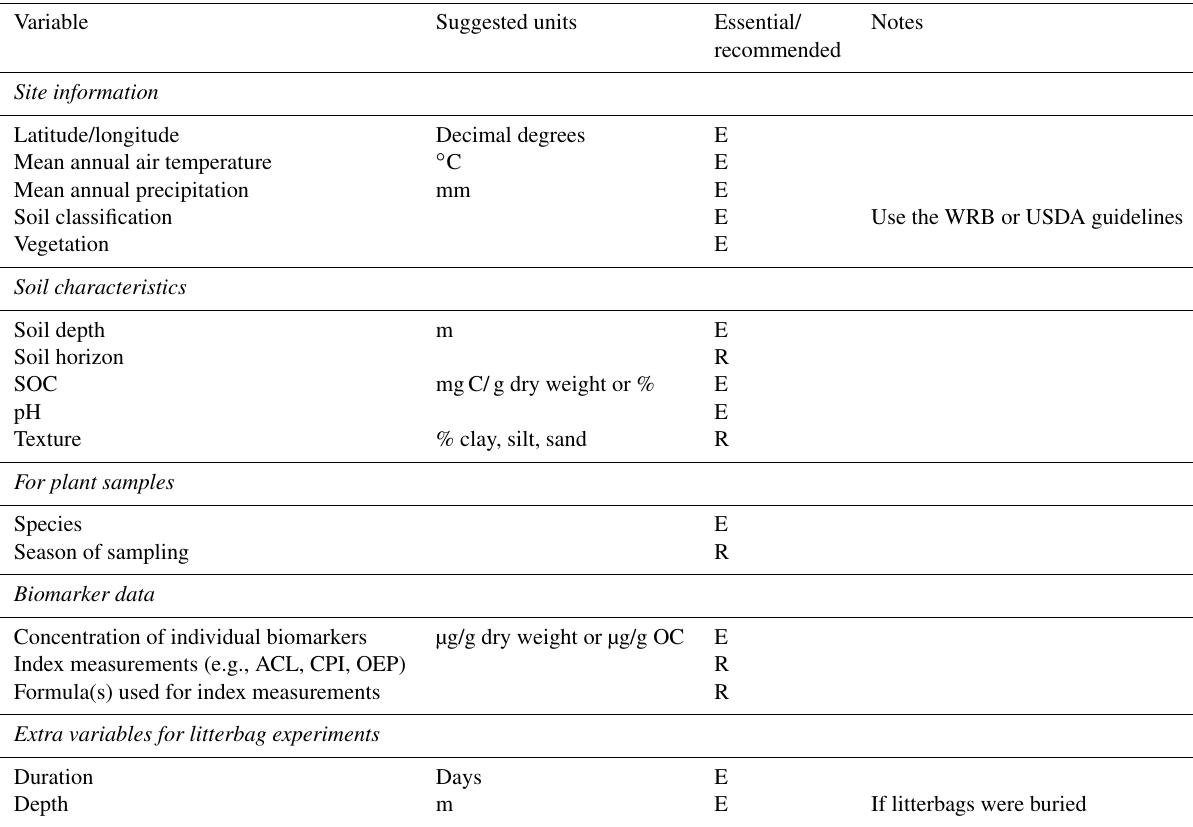
Table 3. Data-reporting guidelines adapted from Schädel et al. (2020).